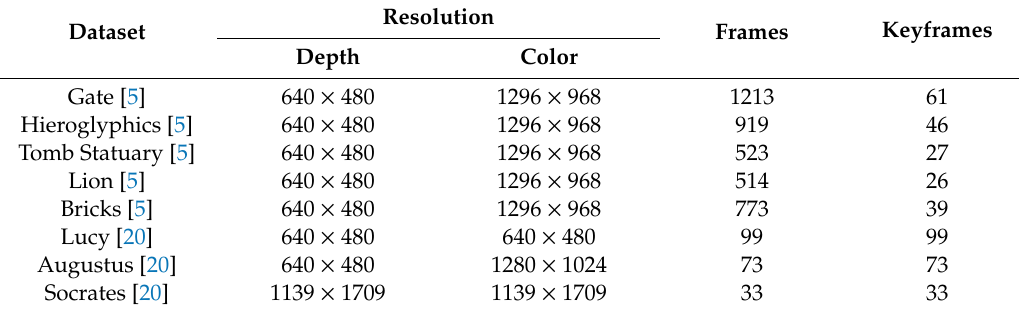
Table 1. The RGB-D dataset for evaluation.